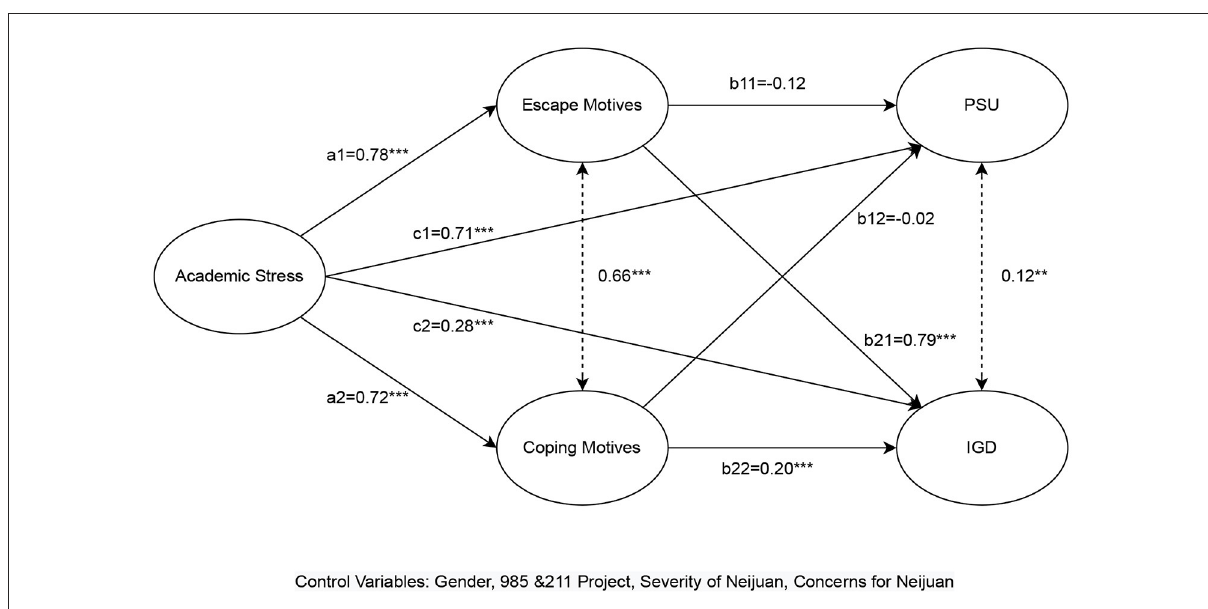
FIGURE1 Results of mediational analysis. Path coefficients are unstandardized. N = 580. * p < 0.05, ** p < 0.01, *** p <